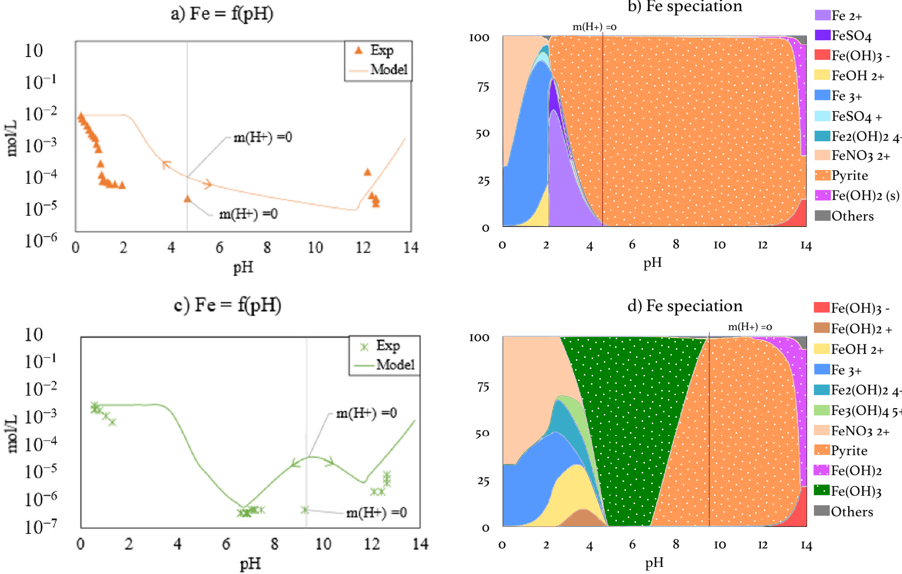
Figure 5. Total experimental soluble content and modeled speciation of iron as a function of pH: ( a , b ) pyrite/SiO 2 and ( c , d ) calcite/pyrite/SiO 2 . Arrows indicate the direction of addition or depletion of protons; the vertical line indicates the point of equilibrium with pure water (natural pH).